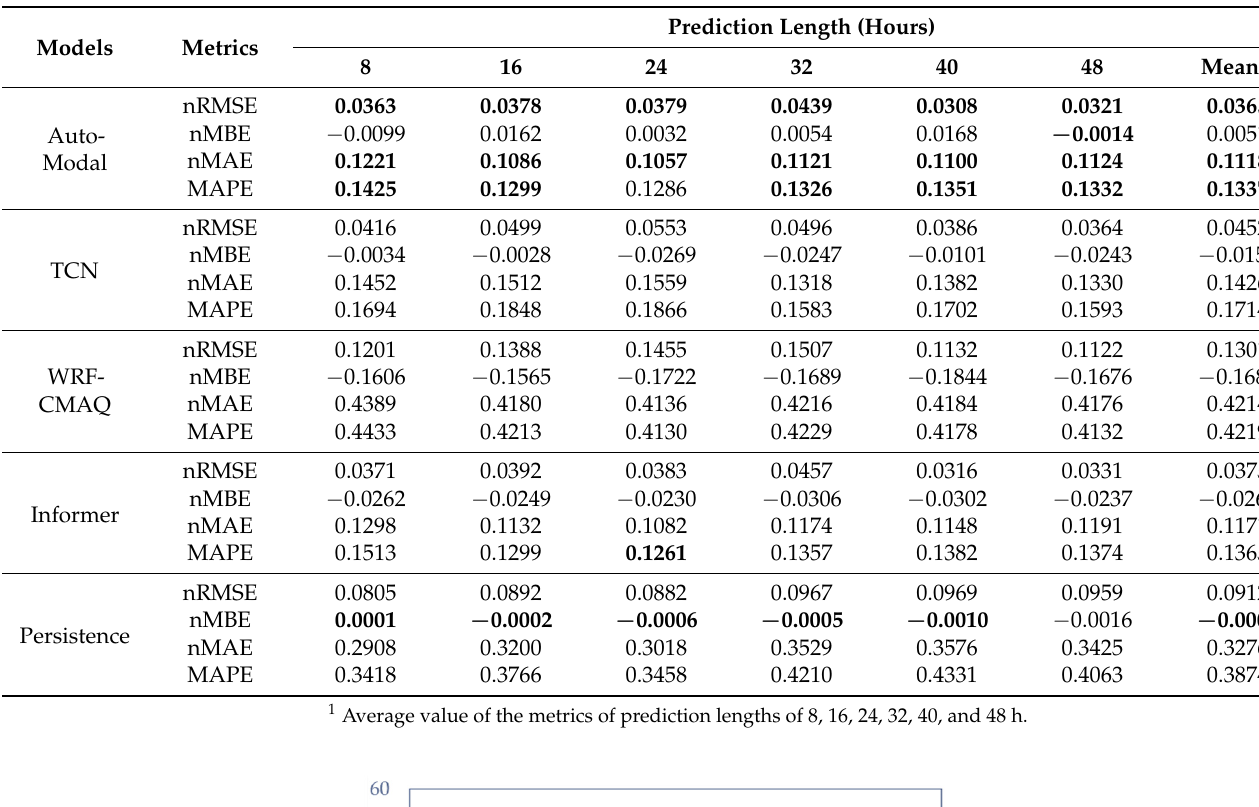
Table 4. Metrics of the auto-modal and prediction models with different prediction lengths.